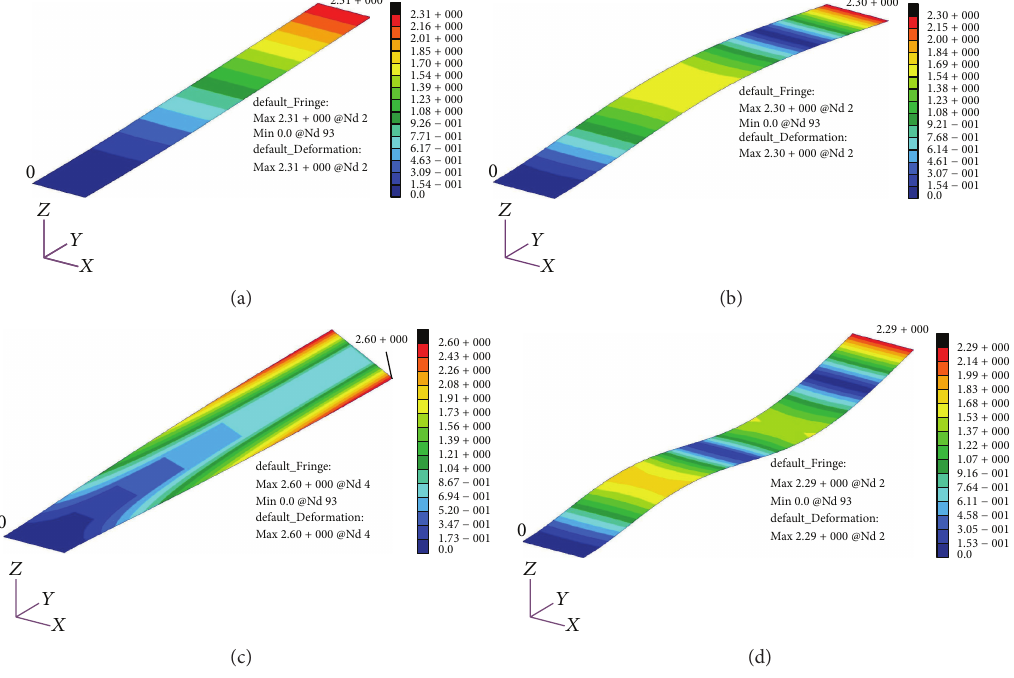
Figure 6: First four (a, b, c, d) modes of the rectangular